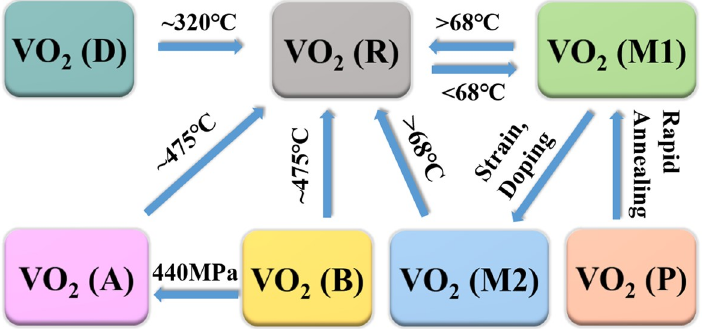
Figure 2. Diagram of phase transformations between different phases of VO 2